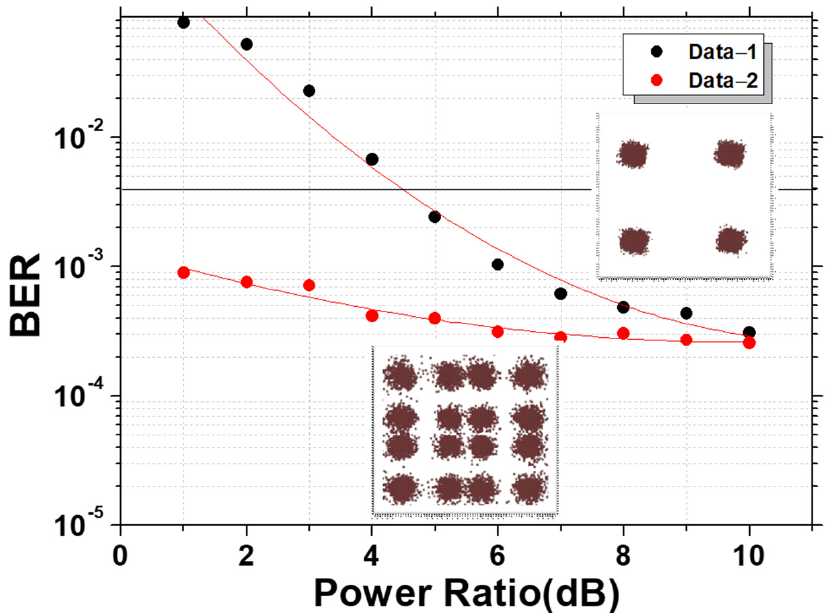
Figure 4. Measured BER against power ratio of Data 2 to Data 1 of the PowDM VLC system. Insets: constellation diagrams of Data 1 and Data 2.